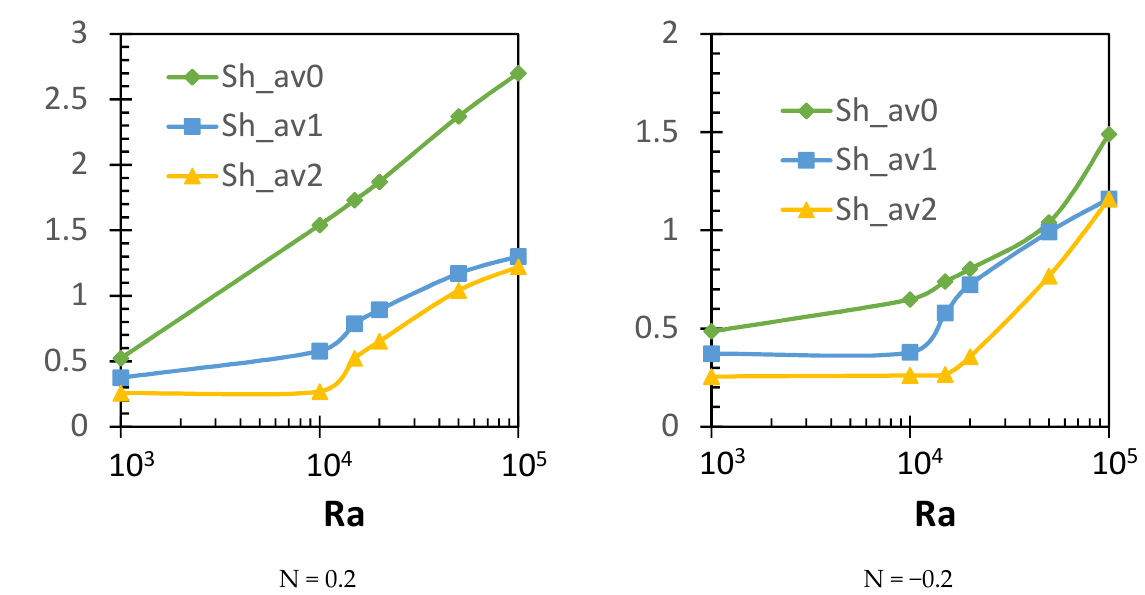
Figure 19. Effect of the Rayleigh number on the average mass transfer ratios for N = 0.2 and N=−0.2, (0): reference case, (1): H 1 = 0.25 and (2) for H 2 = 0.5.